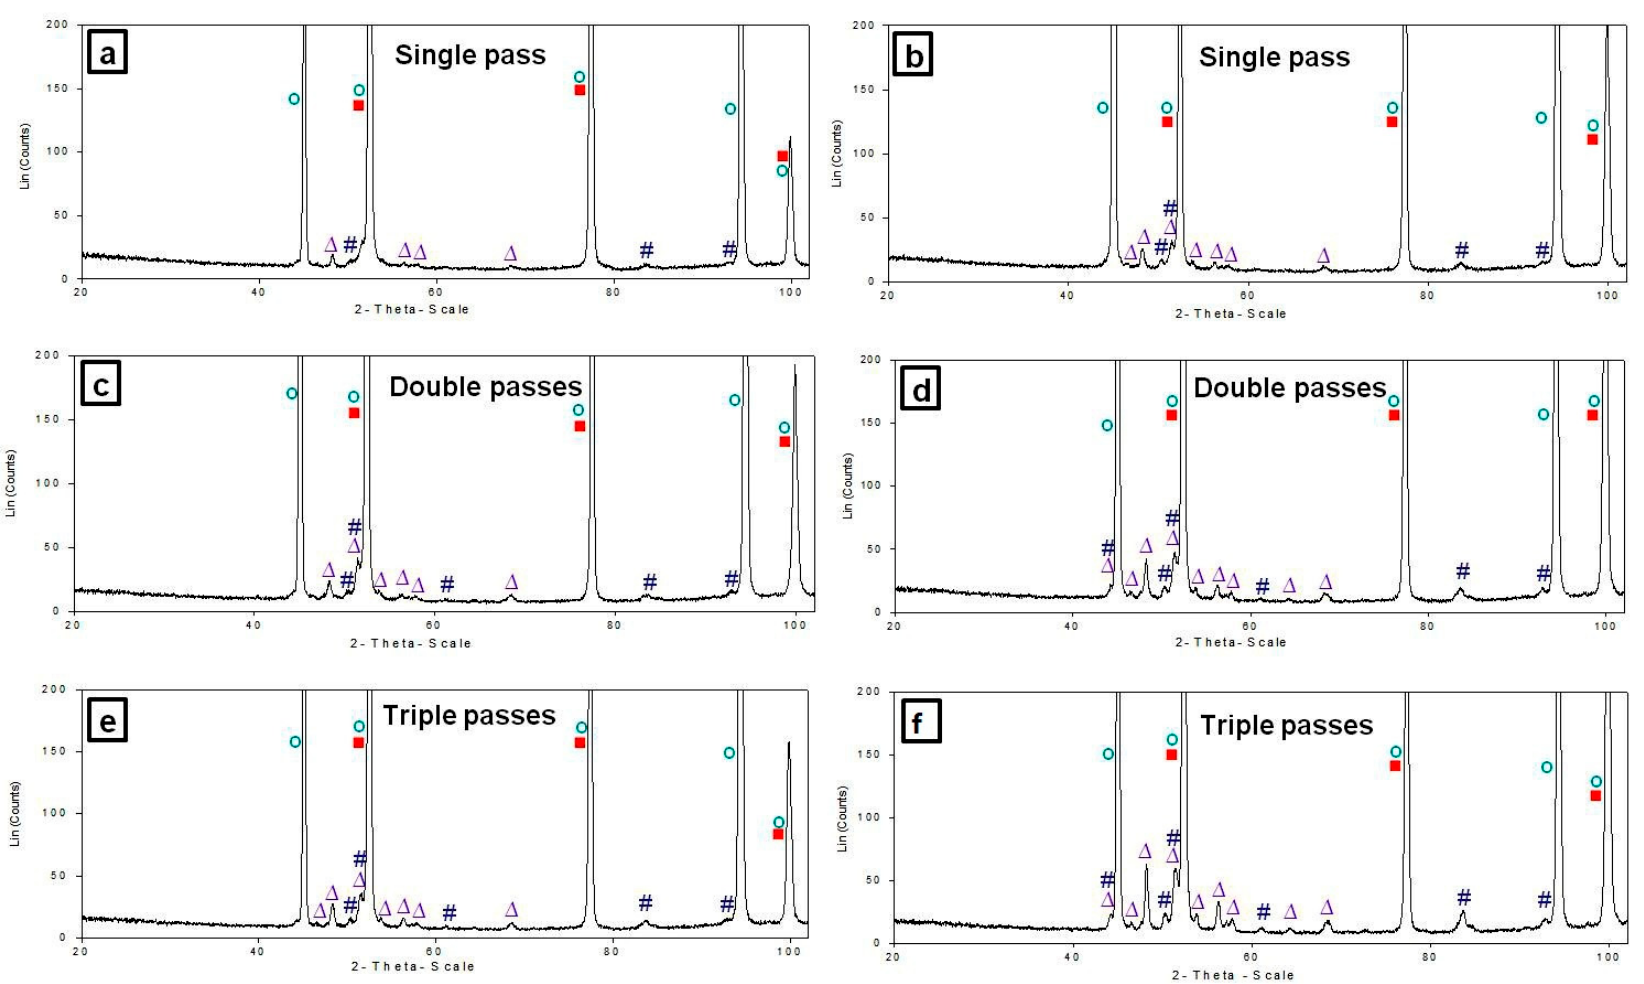
Figure 2. XRD patterns of nugget zones cross-sections (Al-Fe) after single, double and triple FSP passes at following rotation speeds: ( a , c , e ) 1000 rpm; and ( b , d , f ) 1500 rpm. ( Al, (cid:4) Fe, ∆ Al 3 Fe, # Al 5 Fe 2 (cid:35)